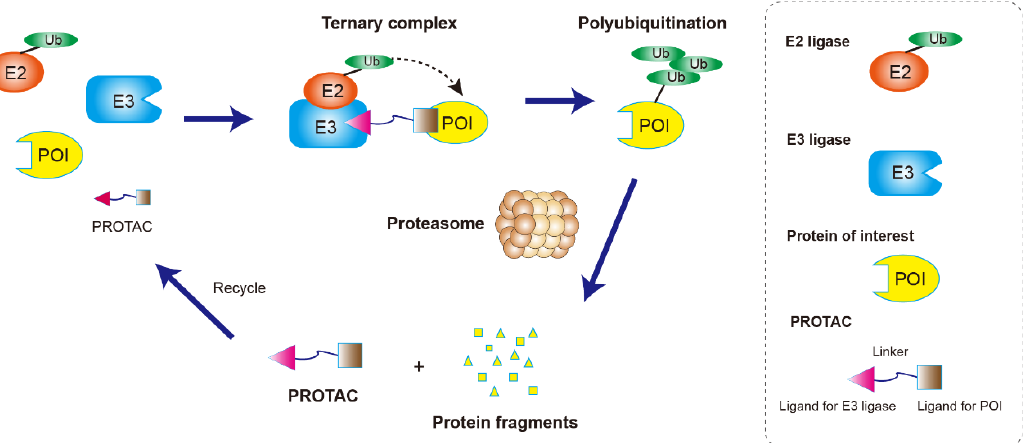
Figure 1. Illustration of the PROTAC mechanism. PROTACs are composed of a ligand that binds to a protein of interest (POI) which is tethered to another ligand that binds to the ubiquitin ligase enzyme through a short chemical linker. A POI-PROTAC-E3 ligase ternary complex is formed which leads to tagging of the protein of interest with ubiquitin groups. The proteasome then recognizes the polyubiquitination signal and mediates the degradation of the target protein. The PROTAC molecule can be recycled for another degradation